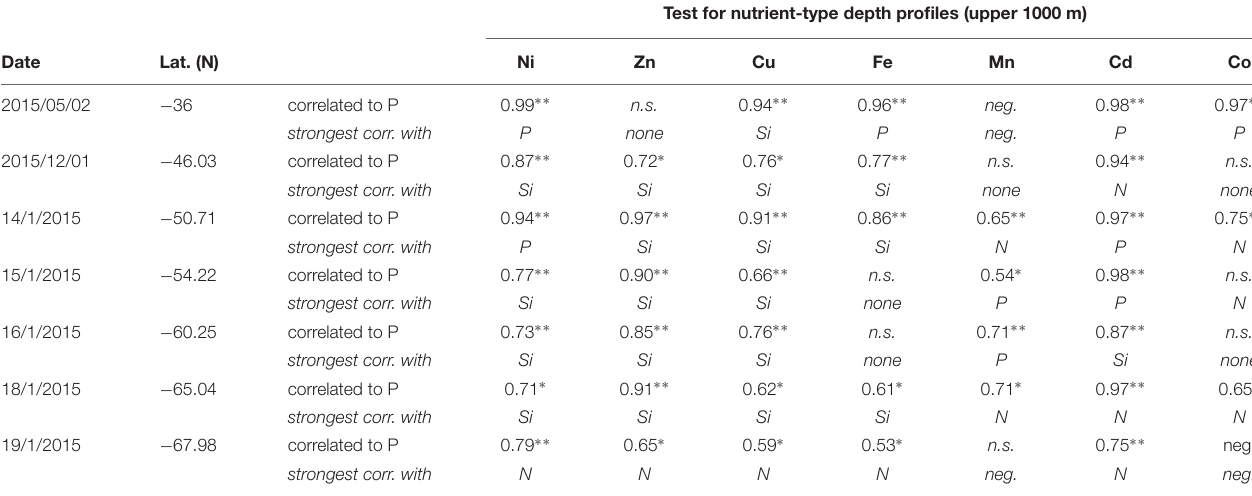
TABLE 2 | Assessment of nutrient-type behavior considering depth profiles over the upper 1000 m of the water column. Test for nutrient-type depth profiles (upper 1000 m)